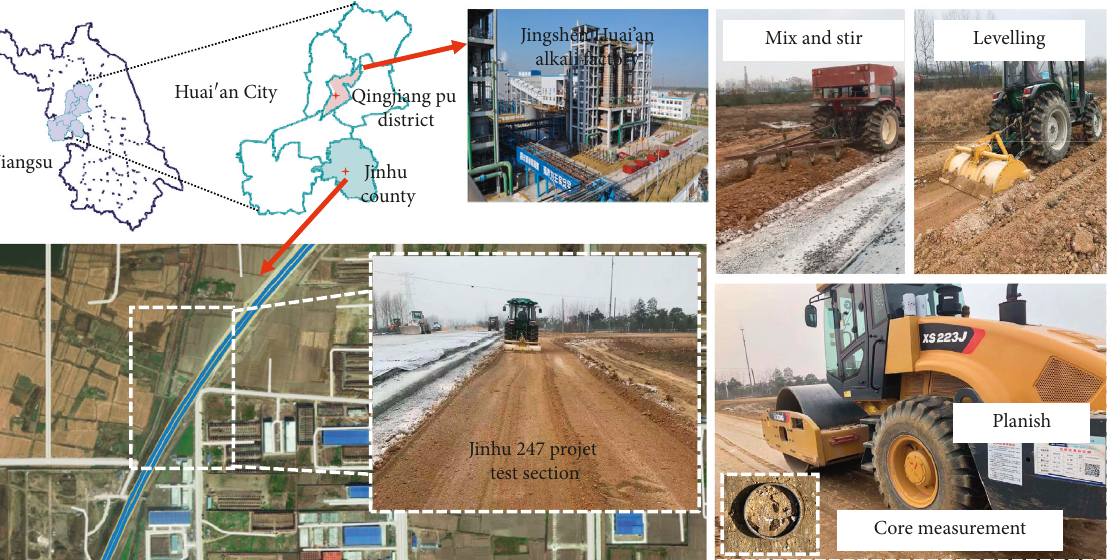
Figure 12: A schematic of the geographical location of the test section and actual image on-site.